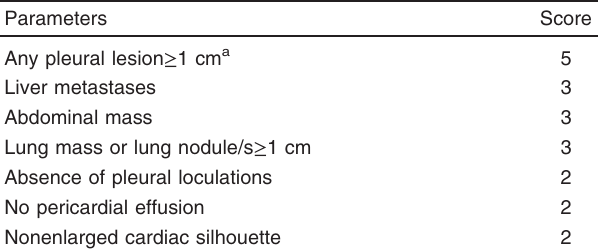
Table 1 Computed tomography scan score for predicting the malignant etiology of pleural effusions